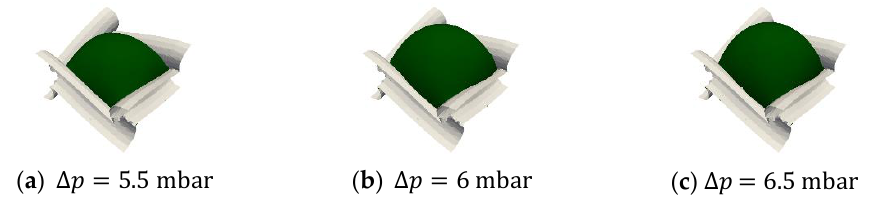
mbar Figure 9. Shape of the glycerol – air interface (green) at different pressure boundary conditions (val-